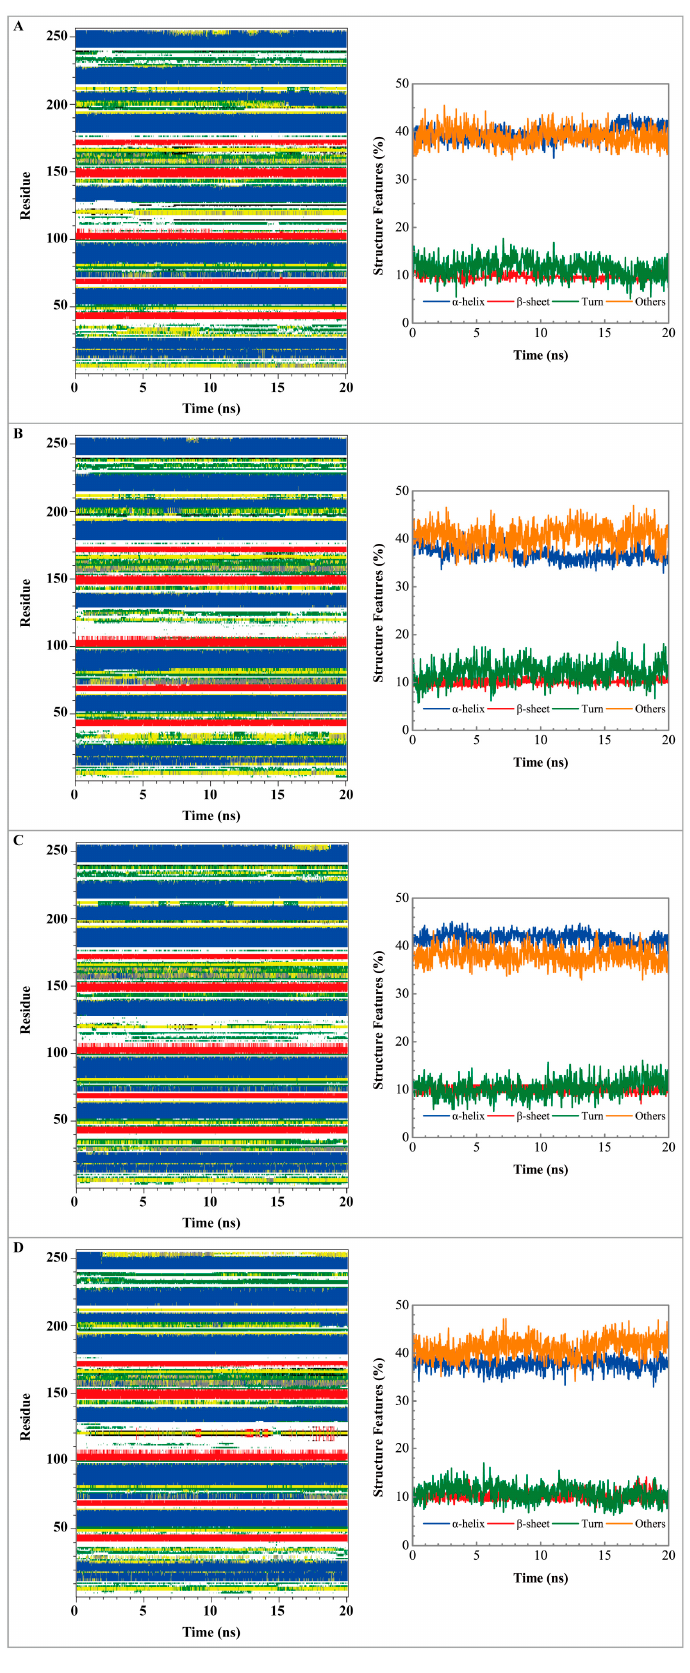
Figure 7. Secondary structure assignment and secondary structural feature ratio variations for paraplegin protein in ( A ) apo form and complexes with ( B ) 5-hydroxy- L -tryptophan; ( C ) saussureamine C; and ( D ) -(2-carboxyphenyl)-4(3 H